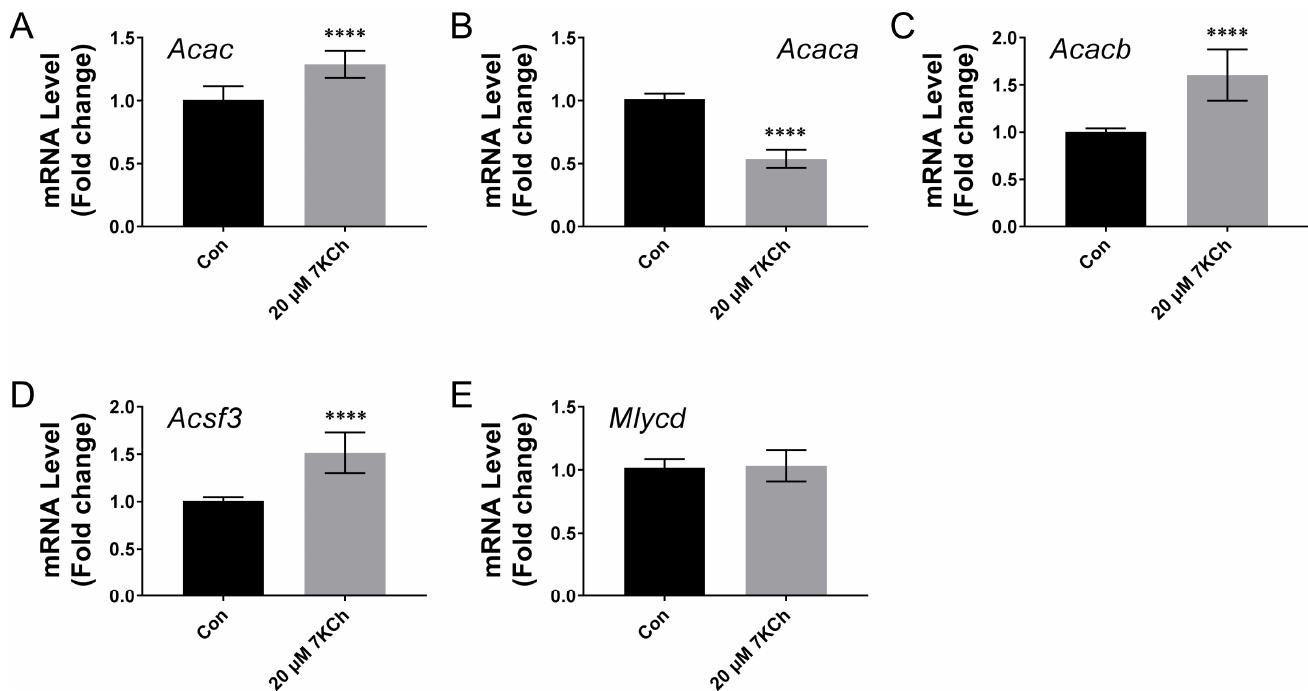
Figure 8. The transcription of the genes encoding malonyl-CoA metabolizing enzymes is regulated by 7KCh. The HL-1 cells were treated with 0 (i.e., the vehicle control; Con ) or 20 µ M 7KCh, and the total RNA was extracted for the qRT-PCR-based quantification of expression of the Acac ( A ) (i.e., all transcript variants encoding different acetyl-CoA carboxylase isoforms), Acaca ( B ), Acacb ( C ), Acsf3 ( D ), and Mlycd ( E ) genes. The abundances of these metabolites are expressed as the fold change relative to the untreated control. Data are mean ± SD, N = 12. **** p < 0.001 vs. the untreated control.